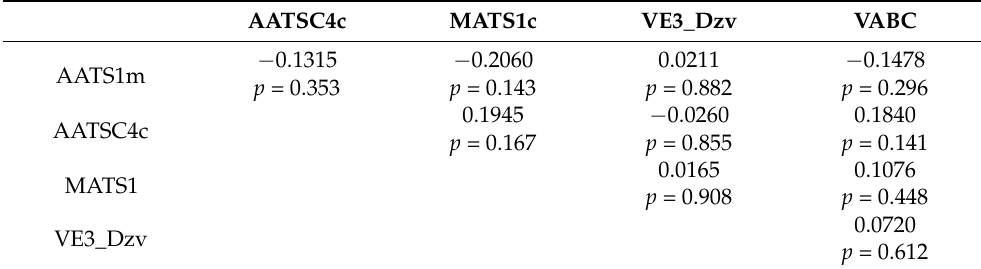
Table 2. Correlations between molecular descriptors for H. italicum essential oil.